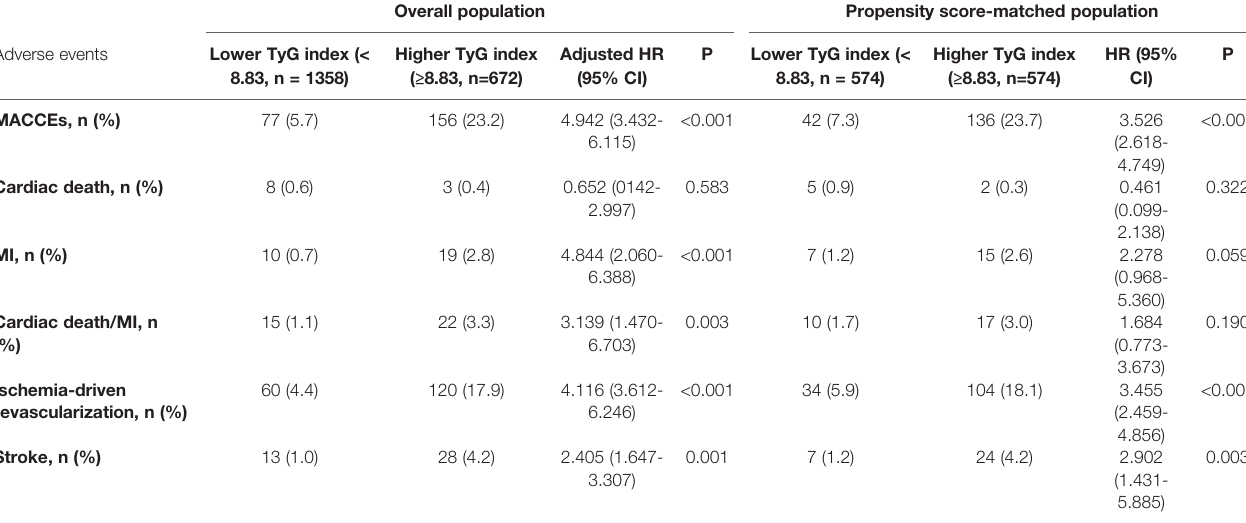
TABLE 4 | Estimated Kaplan – Meier events rates of 2.5 years